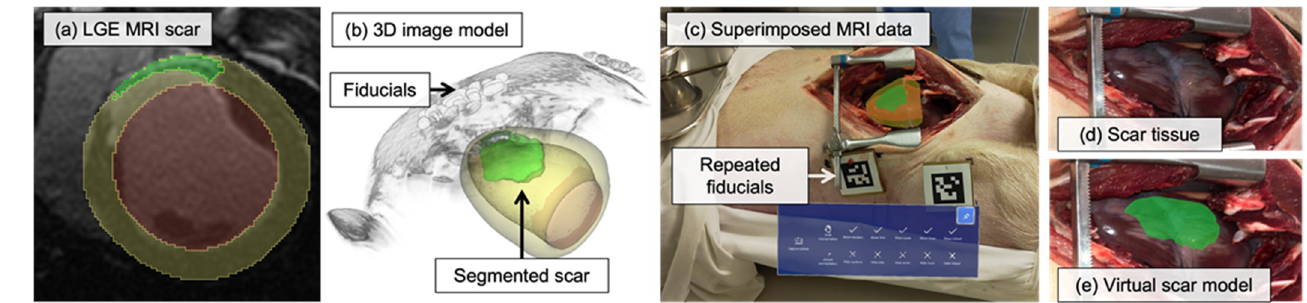
Figure 7. Results from the porcine feasibility study. ( a ) Segmented left ventricle myocardium and blood pool structures from cine MRI (yellow, red) and myocardial scar tissue from LGE MRI (green) at the 30-min timepoint after Gd injection. ( b ) Structures segmented from MRI as a smoothed 3D model with transparency applied. The MRI visible fiducials (Vitamin E caplets) are visible on the skin of the animal. ( c – e ) A single 2D view of the stereo 3D view (which a user wearing the HMD would see) was captured using the HoloLens 2 mixed reality capture capability, which is known to introduce an offset in the position of virtual models. The virtual model is shown aligned with the heart, and a user-interface is included to allow for control of virtual model mesh visualization. All images were recorded after animal sacrifice, resulting in higher scar to myocardium contrast from blood washout.